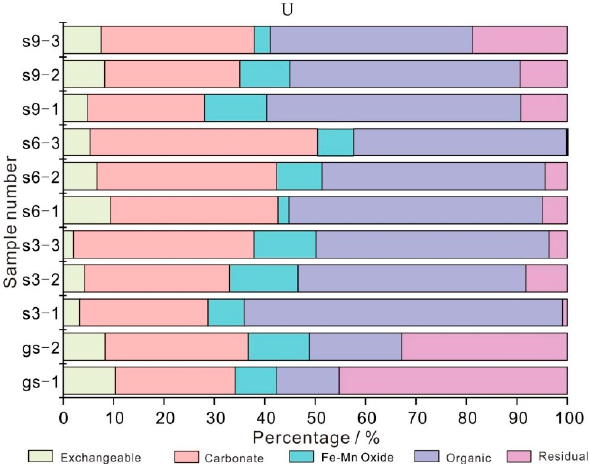
Figure 5. The modes of occurrence for U element in coal gangue and soil profile.